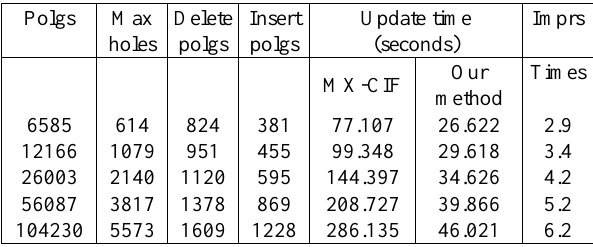
Figure 4. Experimental test Vector Land Cover Data before Updating